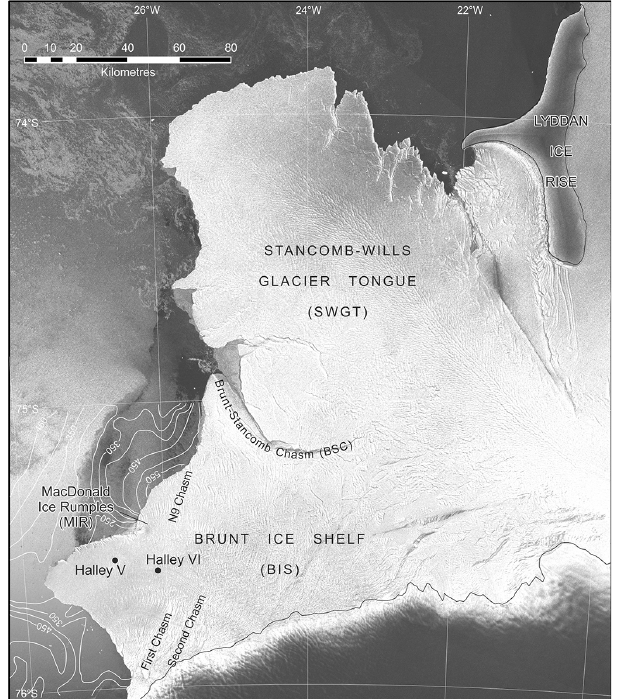
Fig. 2. Location of Halley V and Halley VI on Brunt Ice